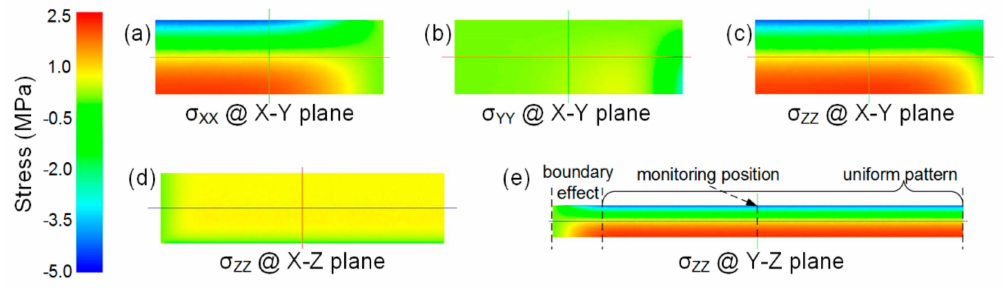
Figure 7. Contour of stress distribution on different planes. ( a – c ) σ XX , σ YY , and σ ZZ on the X-Y plane; ( d , e ) σ ZZ on the X-Z and Y-Z